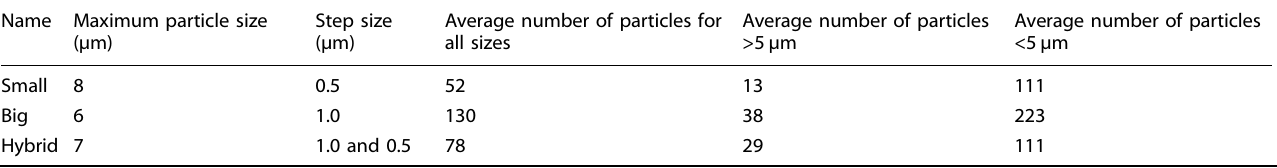
Table 1. Description of each size bound used and the average number of particles found within the bounds.